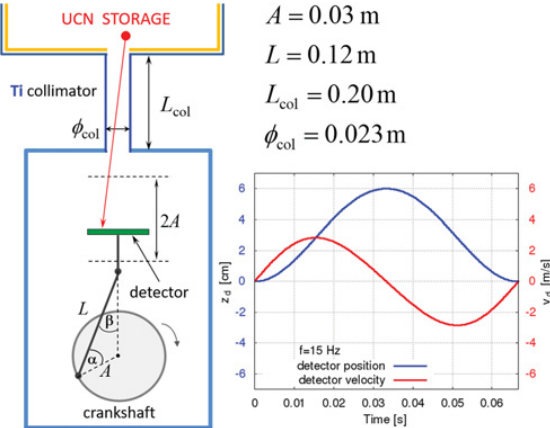
Figure 1. General conception of the UCN oscillating spec- trometer. Left panel: Crankshaft oscillator. The blue line marks the UCN absorbing materials: the titanium collimator with = − 45neV) and the aluminium negative Fermi potential ( V F col = 3 . 2 m/s. The yellow walls of chamber with Fermi velocity v F Al = line identifies the UCN reflector with Fermi velocity ( v F s 6 . 3 m/s) typical for storage vessel. The green box denotes the detector surface with Fermi velocity v F = 4.0 m/s. Right panel: d Time dependence (within one oscillation period) of the detector position z d and detector velocity v d